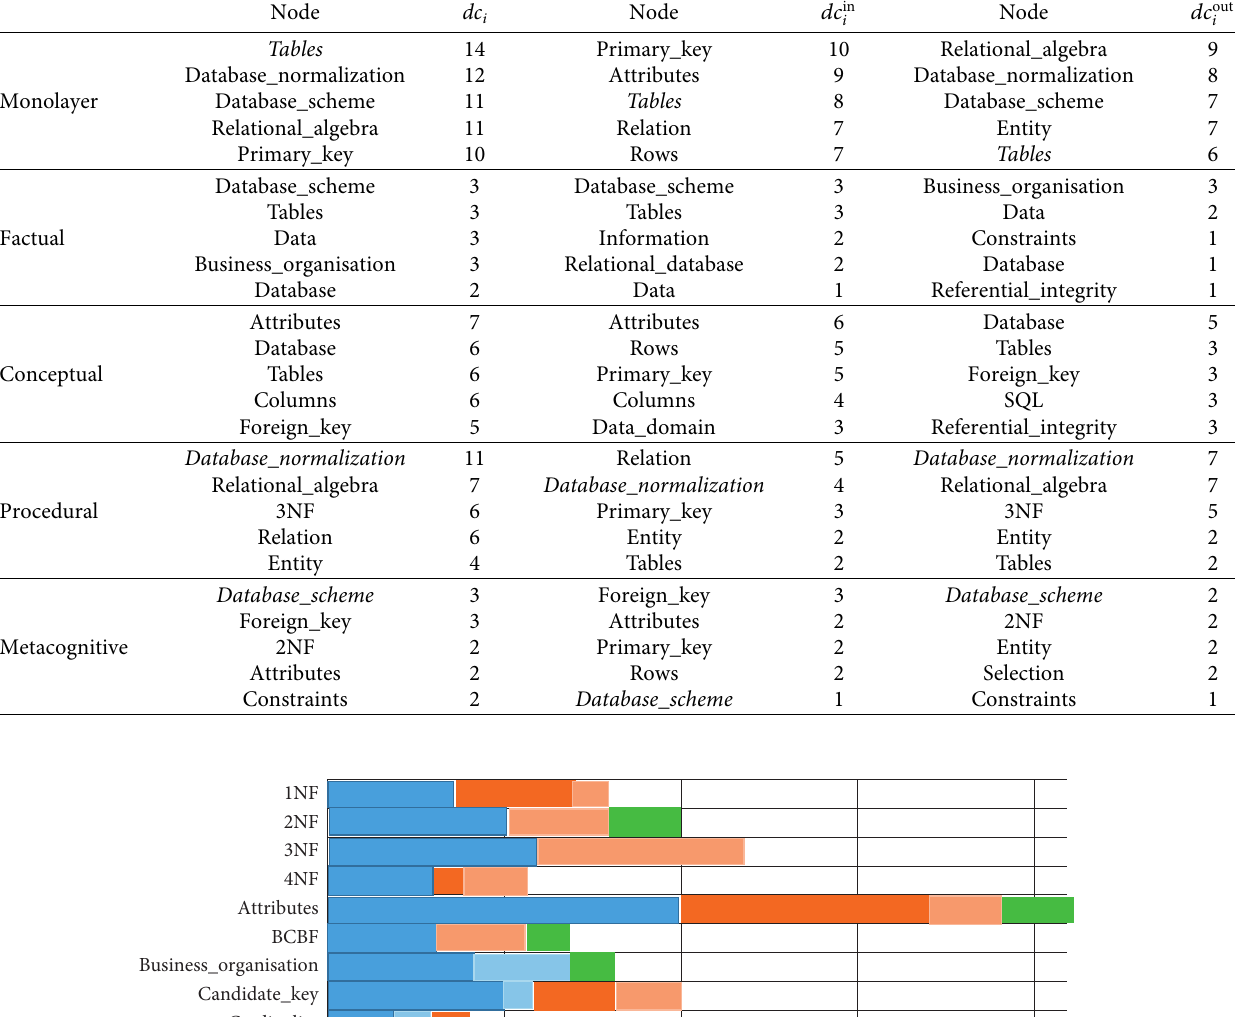
Table 2: Top five highly ranked nodes according to the degree ( dc